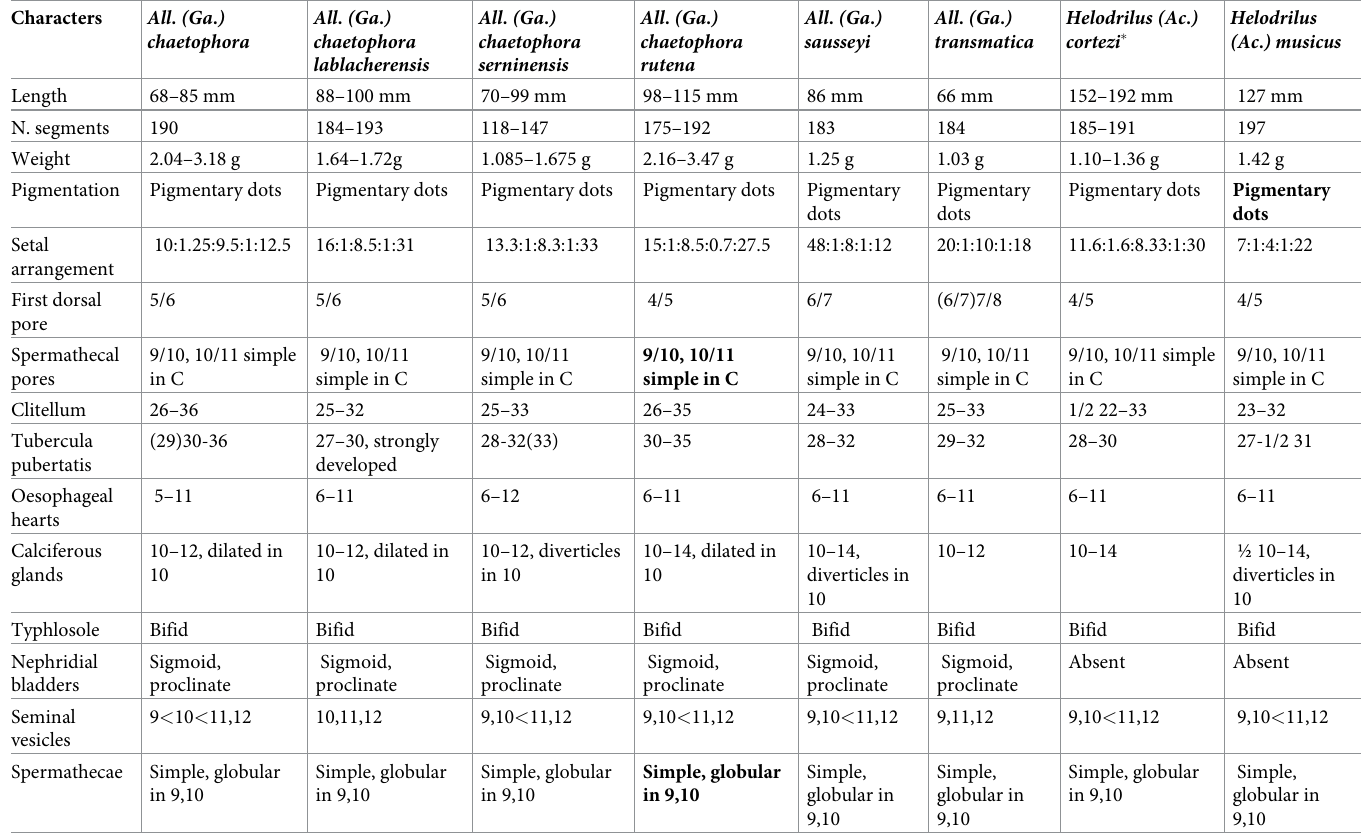
Table 3. Main morphological characters of the species and subspecies of Allolobophora ( Gatesona) and related Helodrilus (Acystodrilus) species under study.